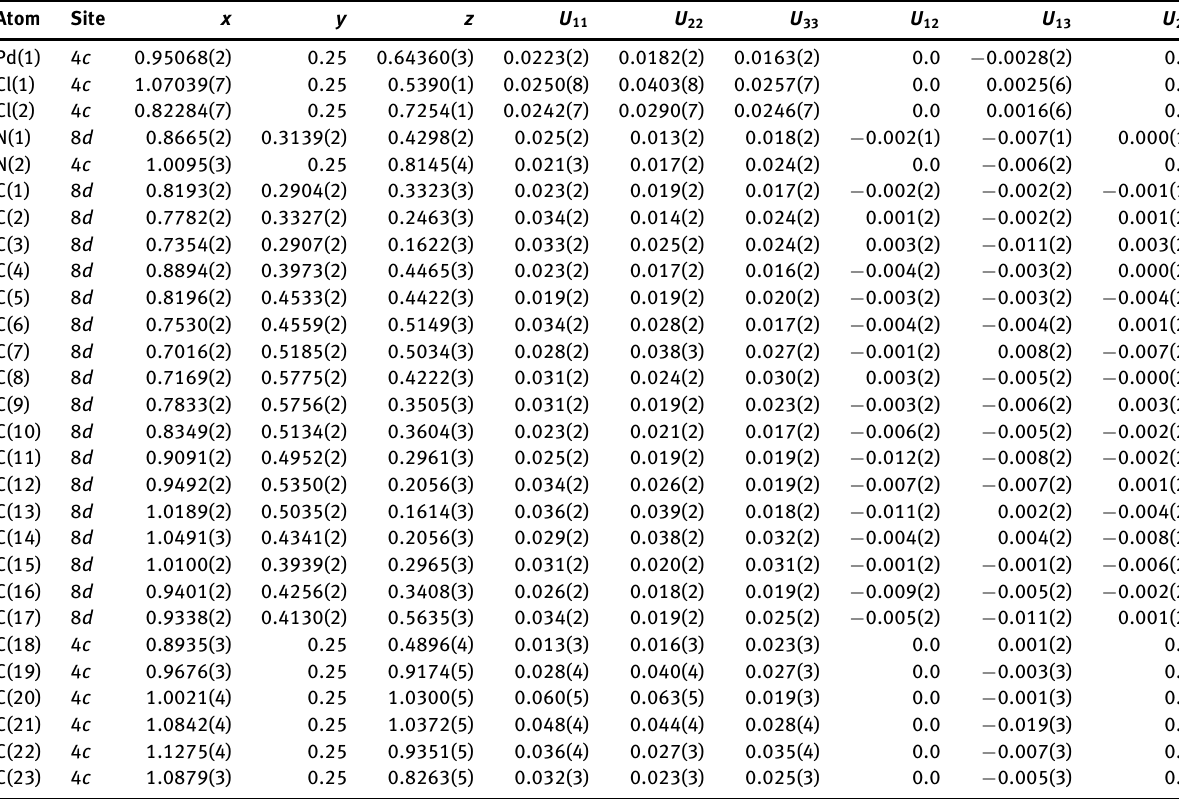
Table 3: Fractional coordinates and atomic displacement parameters (Å 2